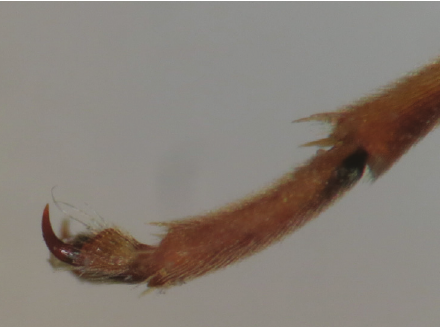
Figure 13. Hellwigia elegans , hind claw